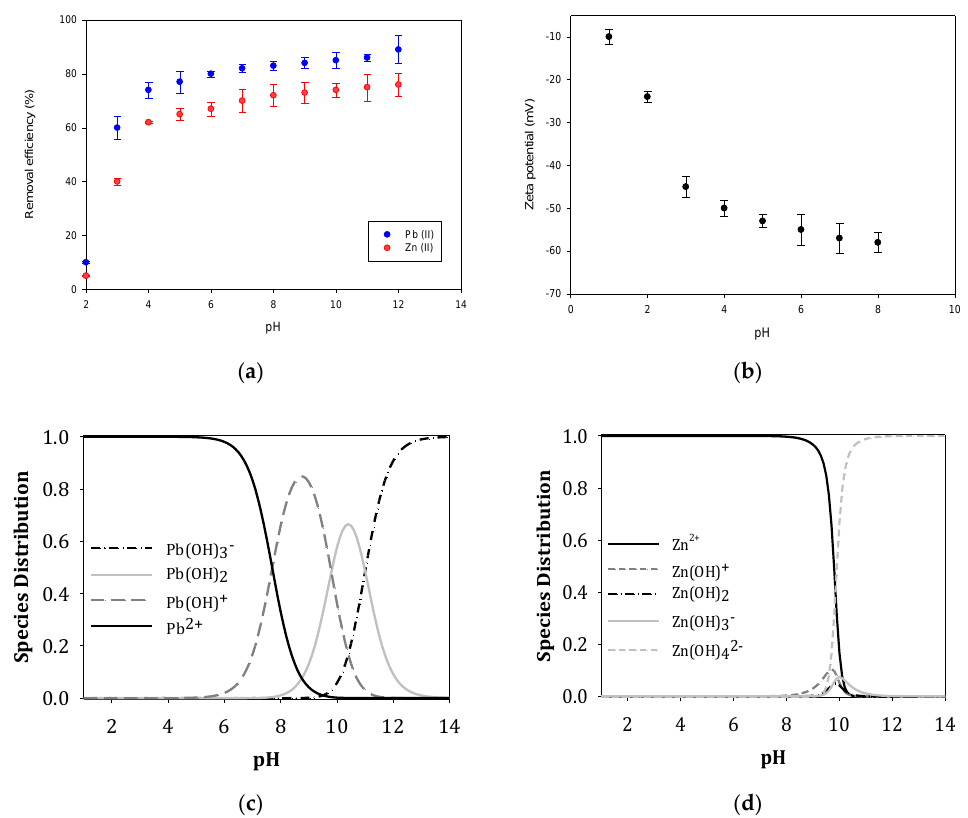
Figure 10. ( a ) Influence of pH on the adsorption of the metal ions Pb (II) and Zn (II) on GO (C o = 5 mg L −1 , C GO = 0.5 mL −1 , T = 25 C, t = 210 min). ( b ) Point zero charge. ( c ) Speciation graph of Pb. ( d ) Speciation graph of Zn.